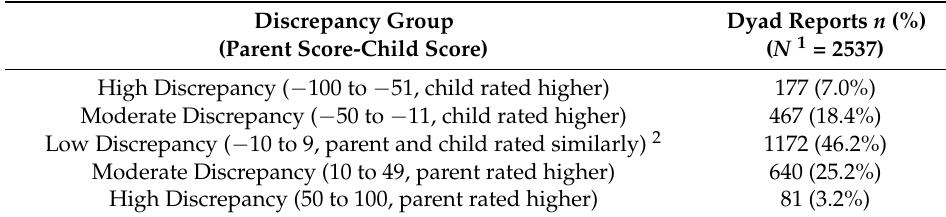
Table 1. Groups of Pain Score Discrepancy.